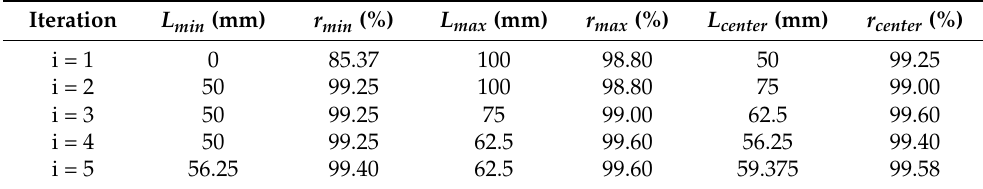
Table 2. The iterative process to find the length of the screen L corresponding to the optimal restitution coefficient r